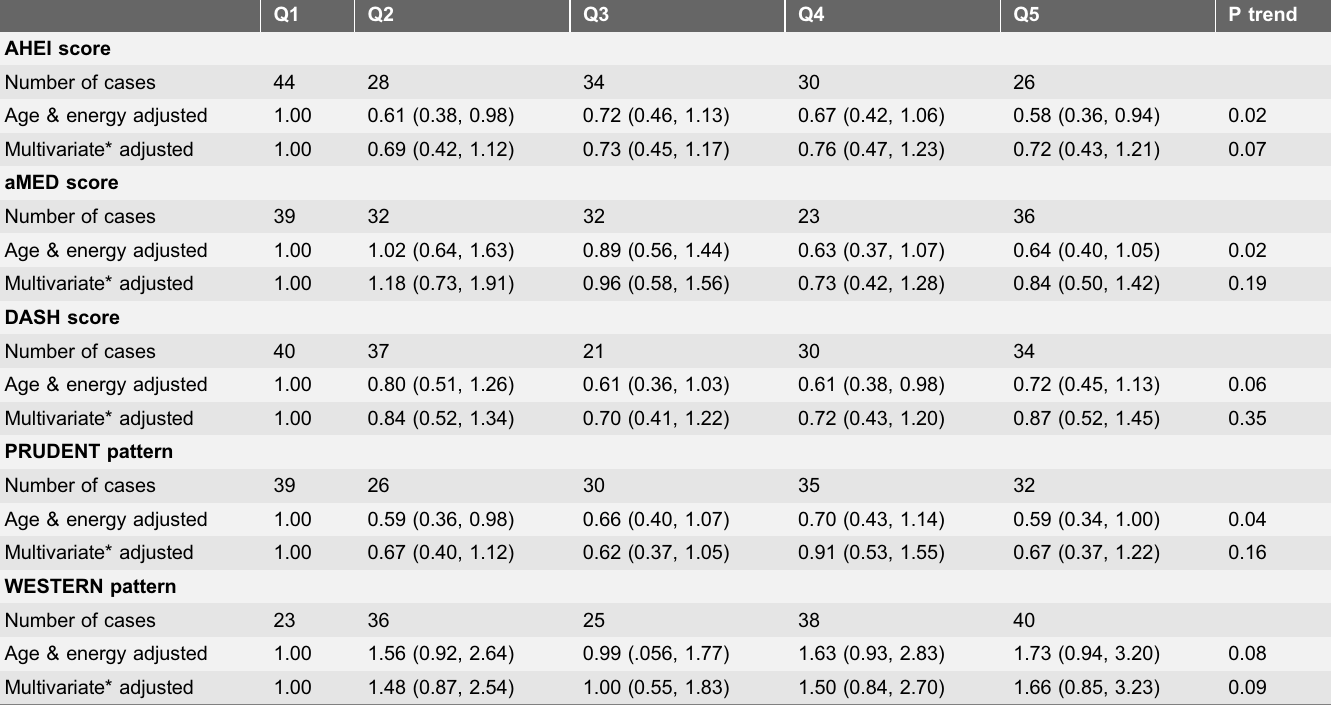
Table 3. Association between quintiles of post-diagnosis diet score (Hazard ratio and 95% CI) and colorectal cancer mortality. Q1 Q2